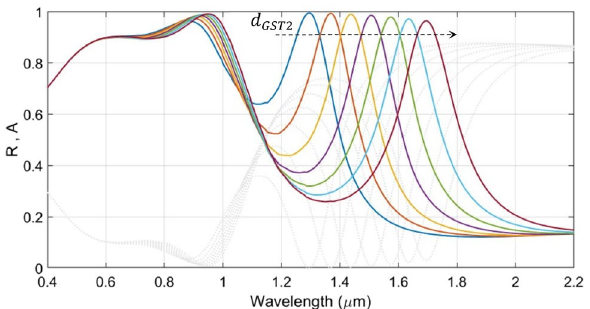
Figure 4. Wavelength dependence of the absorbance A (and reflectance R ) under fixed d GST1 (= 130 nm) and varying d GST2 ; the other geometrical parameters are as used in Fig. 1. Coloured lines correspond to absorbance; gray dotted lines represent reflectance. The dashed arrow represents increase in d GST2